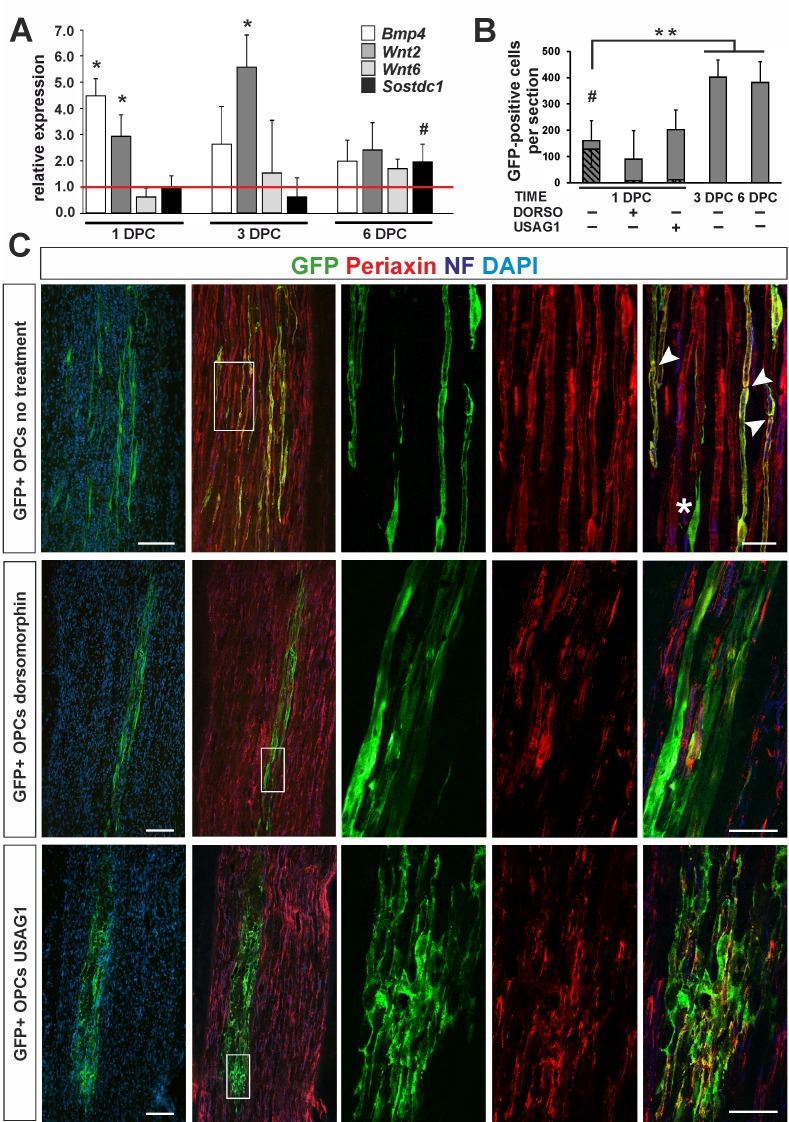
OPC differentiation fate at 4 weeks after transplantation into injured sciatic nerve.(A) Gene expression pattern after sciatic nerve crush (mean ± sd; n = 3, Mann-Whithney U-test, *p<0.01 compared with 30 min after crush, #p<0.05 compared with 3 dpc). (B) Quantification of GFP+ cell number in longitudinal sciatic nerve section in different transplantation paradigms (mean ± sd, three fields per section, three sections per nerve, n = 3 rats per experimental condition, t-Students test, **p<0.01, quantification of GFP+/periaxin+ cells shows their significant contribution in nerves were cells were implanted at 1dpc, shaded bars, # p<0.01). (C) Immunostaining shows grafted cells existing within sciatic nerves at each experimental condition. The first two images of each panel show general view of longitudinal sections in low power, the next three show boxed area reimaged using confocal microscope. Co-localization of GFP (in green), with periaxin (in red) indicates SC differentiation of OPCs grafted into sciatic nerves at 24 hr postinjury, (arrowheads). Non-myelinating GFP+ cells could be also detected (asterisk). SCs differentiation is defective under both dorsomorphin and USAG1 treatment (scale bar 100 μm and 20 μm in low and high power images, respectively).